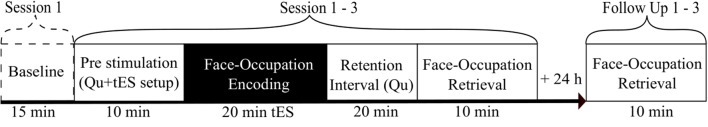
An overview of the study procedure. Each of the three sessions consisted of encoding, consolidation, and retrieval. The retrieval was repeated after 24 h via an online survey. The baseline measurement (cognitive screening, paired associates test) was completed in the first session. Transcranial electric stimulation (tES) was applied during encoding. Different questionnaires (Qu) were given before the encoding and during the retention phase.